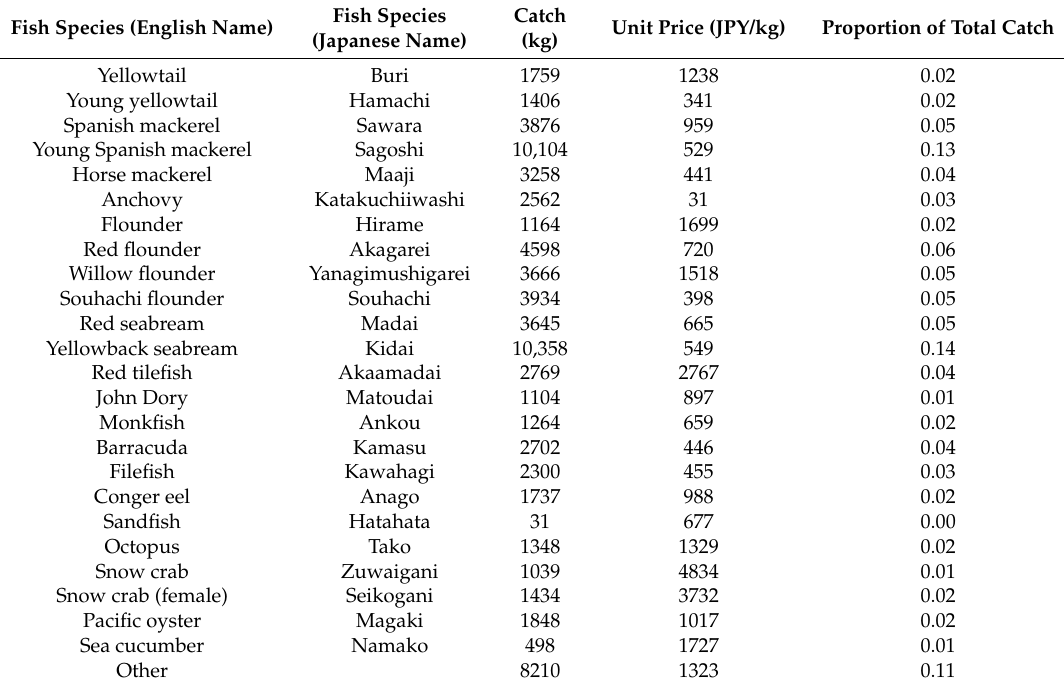
Table 2. Fish volume, prices, and proportion of total catch in Obama (December 2017).